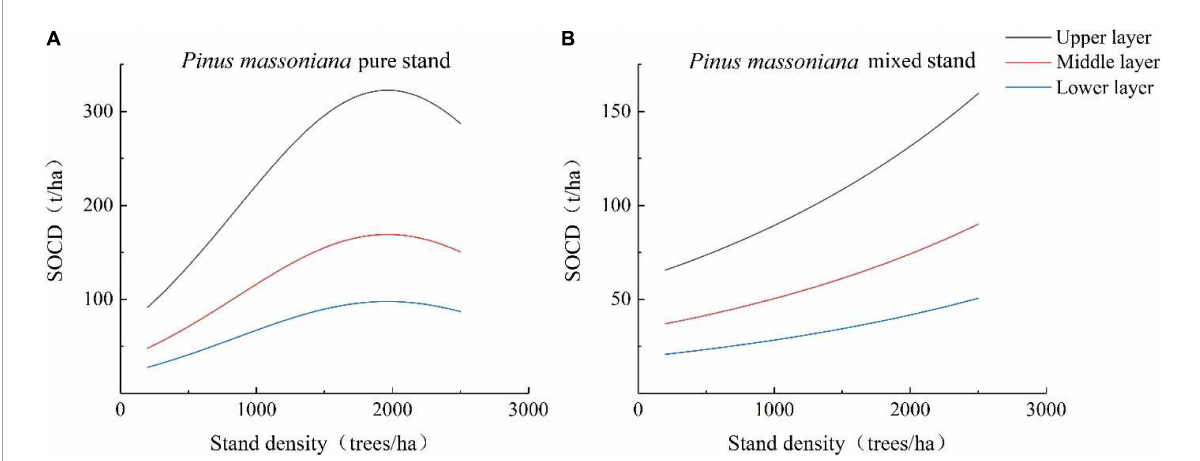
FIGURE1 Soil carbon (SOCD) at different depths and stand densities. (A) SOCD at different depths and different stand densities in pure P. massoniana stands; (B) SOCD at different depths and different stand densities in mixed P. massoniana stand.